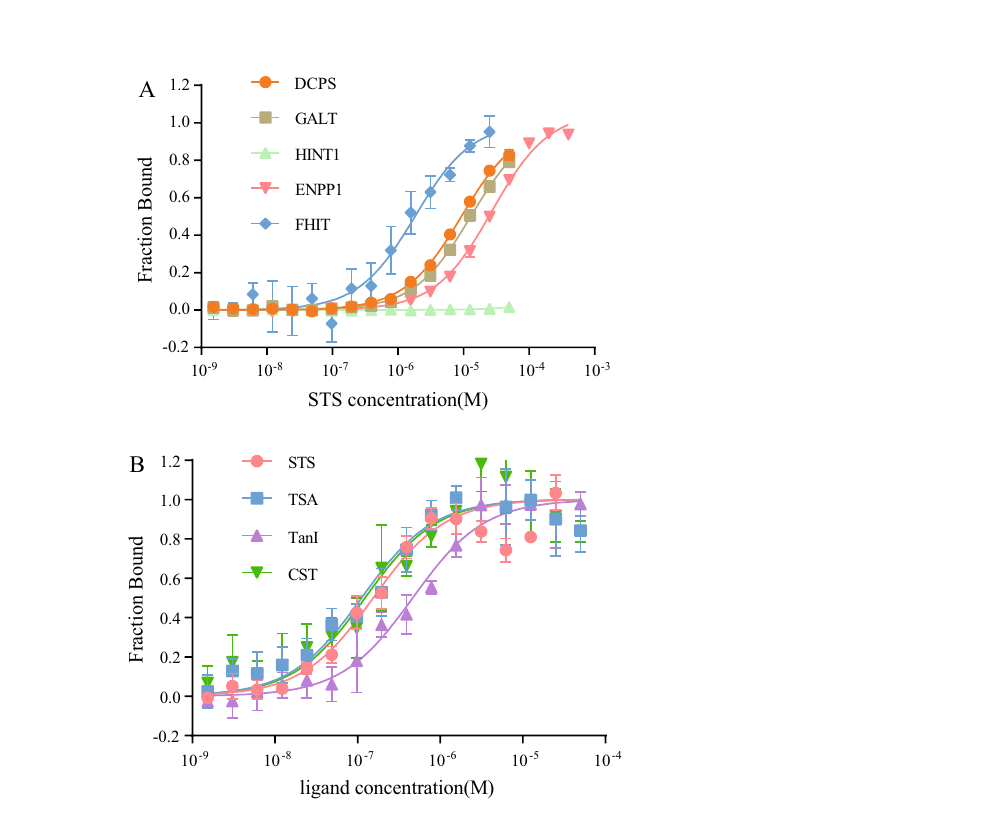
Figure 4. Selectivity assay of the binding between STS and FHIT. ( A ) The binding affinity determination between STS and purified HIT family proteins by MST, and the Kd value was 9.31 ± 0.4 µM for DCPS (orange circle), 12.92 ± 0.54 µM for GALT (celadon square), and 27.22 ± 1.96 µM for ENPP1 (pink inverted triangle). No binding affinity was calculated with HINT1 (light green triangle). FHIT (blue rhombus) was used as a control. ( B ) MST assay of the binding between tanshinone compounds and FHIT, the Kd value is 112 ± 27.3 nM for TSA (blue square), 466 ± 60 nM for TanI (purple triangle), and 123 ± 31.7 nM for CTS (green inverted triangle). STS (orange circle) was used as a